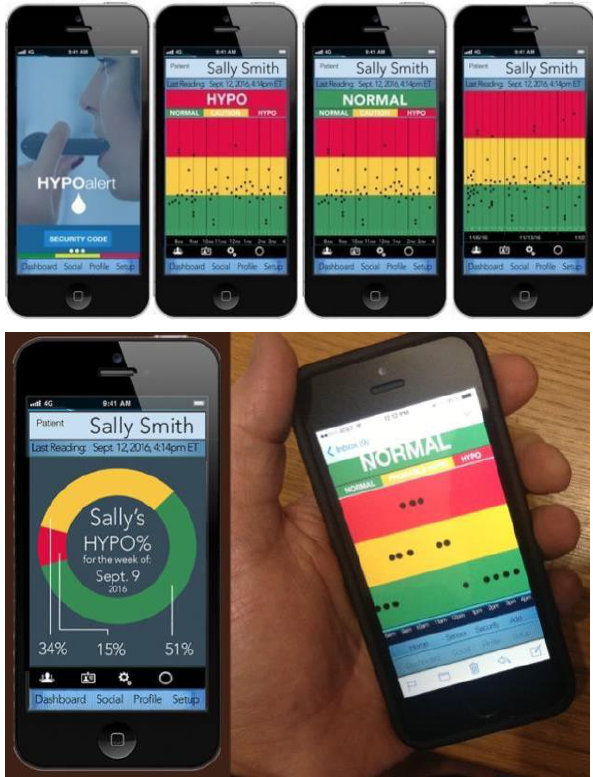
Figure 2. First iteration of the HYPOalert static interfaces. First interface displays the app splash-page, with remaining interfaces indicating the patient’s name and reading date/time. Interfaces 2—3: (1) Three color- coded visualization areas: Green=NORMAL, Yellow=APPROACHING (or Caution), and Red=HYPO, (2) Hourly indication of breathing times and their location on the HYPO visualization scale, and (3) breathing times over several months. On the bottom: Interface (L) display breakdown of the patient’s weekly breathing summary in percentages; and last interface (R) demonstrates HYPOalert on smartphone in